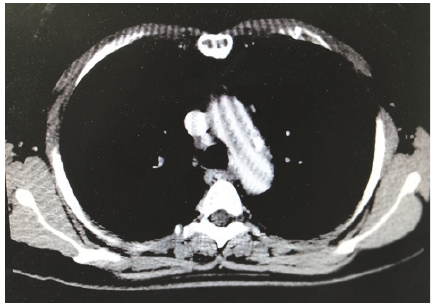
Figure 2: Coronal and axial view of aortic arch depicted the presence of thrombus in a calcified lesion.